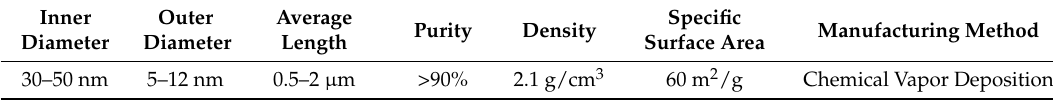
Table 2. Properties of Multiwall Carbon Nanotubes used for Bitumen